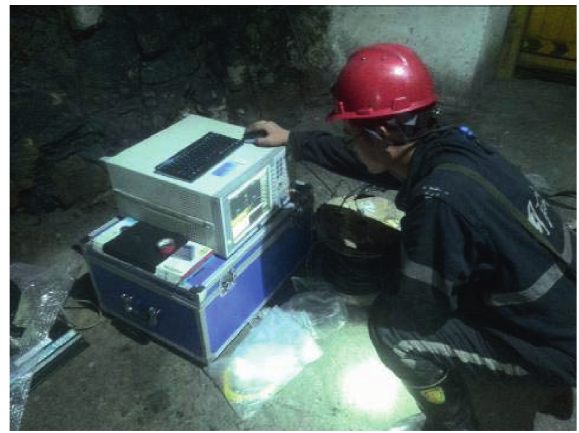
Figure 11: Optical time domain strain measurement